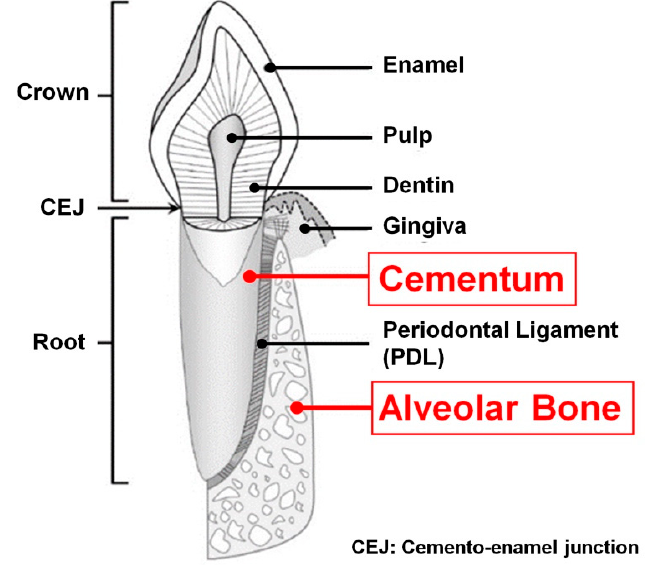
Figure 1. Schematic anatomy of tooth and periodontal tissues (tooth-supporting complex). Alveolar bone and cementum (red-colored terminologies) are typical mineralized tissues of the periodontal complex. Adapted with permission from the reference [5].